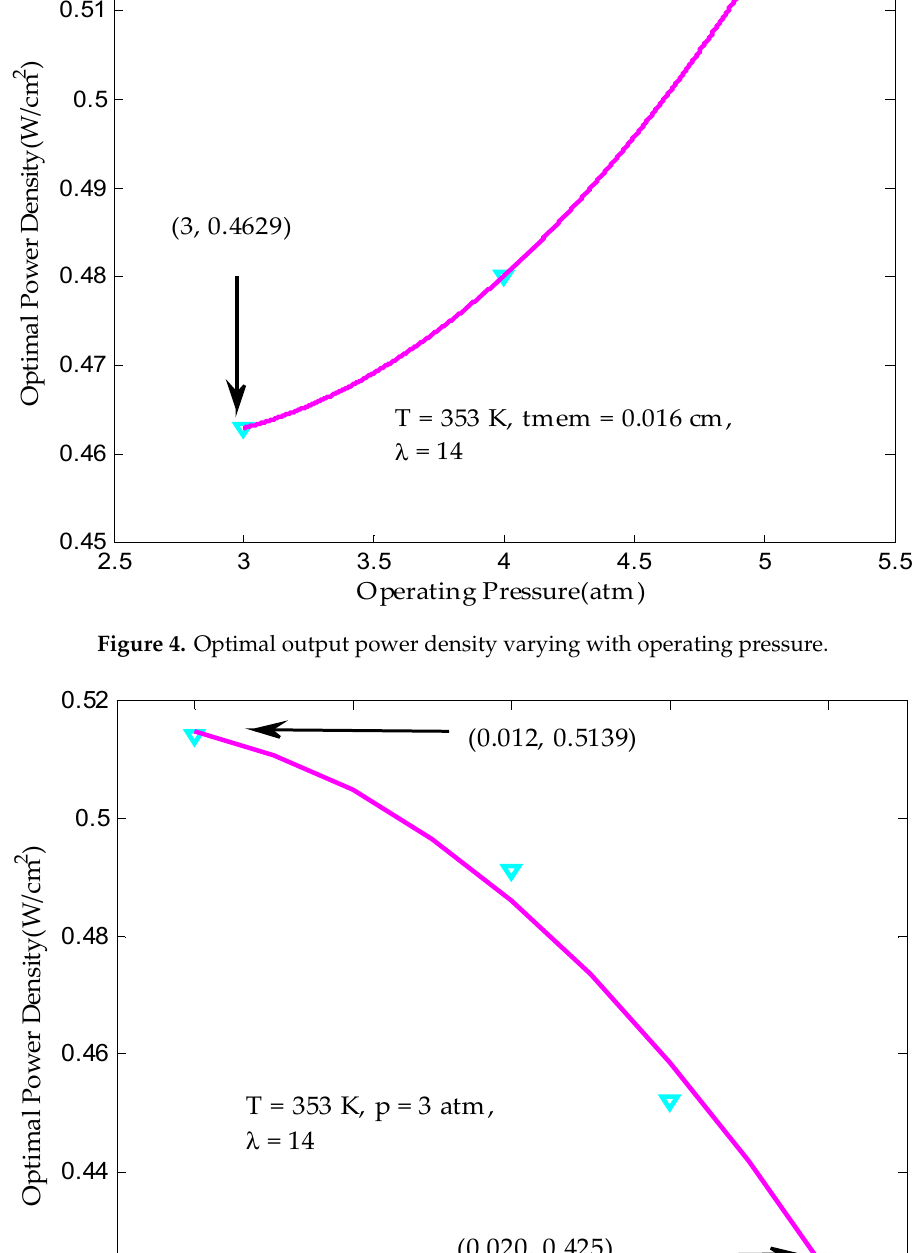
Figure 3. Optimal output power density varying with operating temperature.